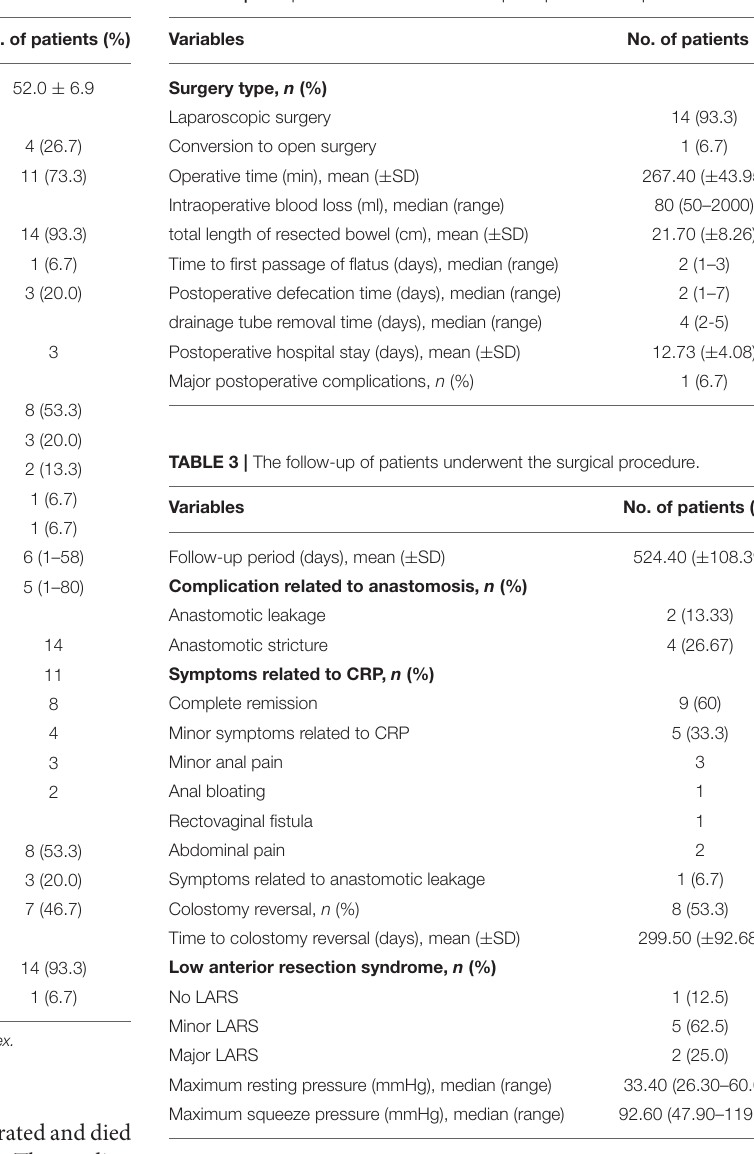
TABLE 1 | Demographics of patients underwent the surgical procedure. TABLE 2 | Perioperative characteristics and postoperative complications.